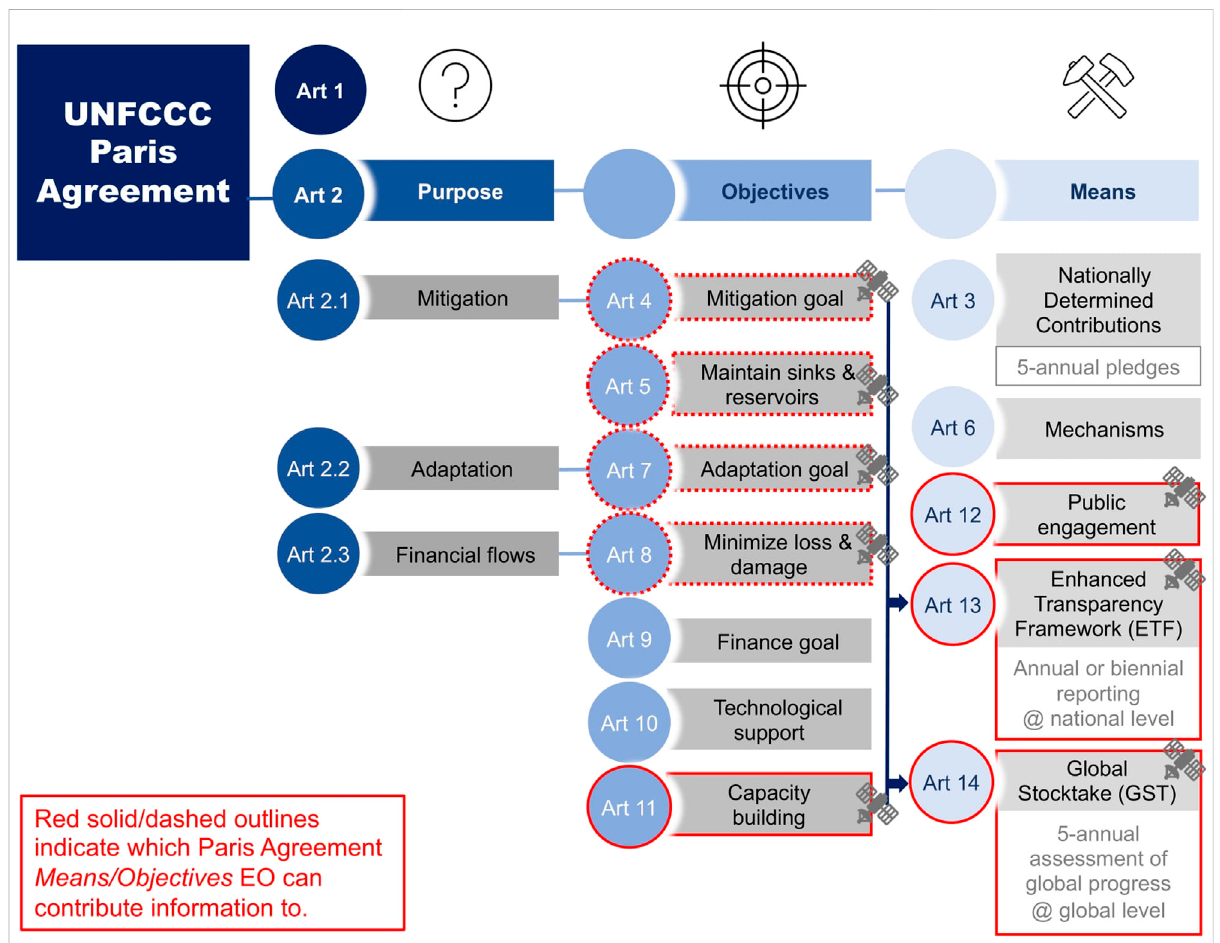
FIGURE 2 TheUNFCCCParisAgreement ’ slegalframework,focusingonthemain Articles andtherelationshipsbetweenthem. Article1 de fi nestheactors, Article 2 the purpose, Articles 4 – 5 and 7 – 11 the objectives, and Articles 3 , 6 , and 12 – 14 the available means of the Paris Agreement. Red circles (and grey satellite icons) denote where there is potential for EO to support the Paris Agreement ’ s objectives (dotted) and available means (solid). The blue vertical line indicates that all objectives are covered in the ETF and GST. Note, the reporting frequency within the ETF depends on the